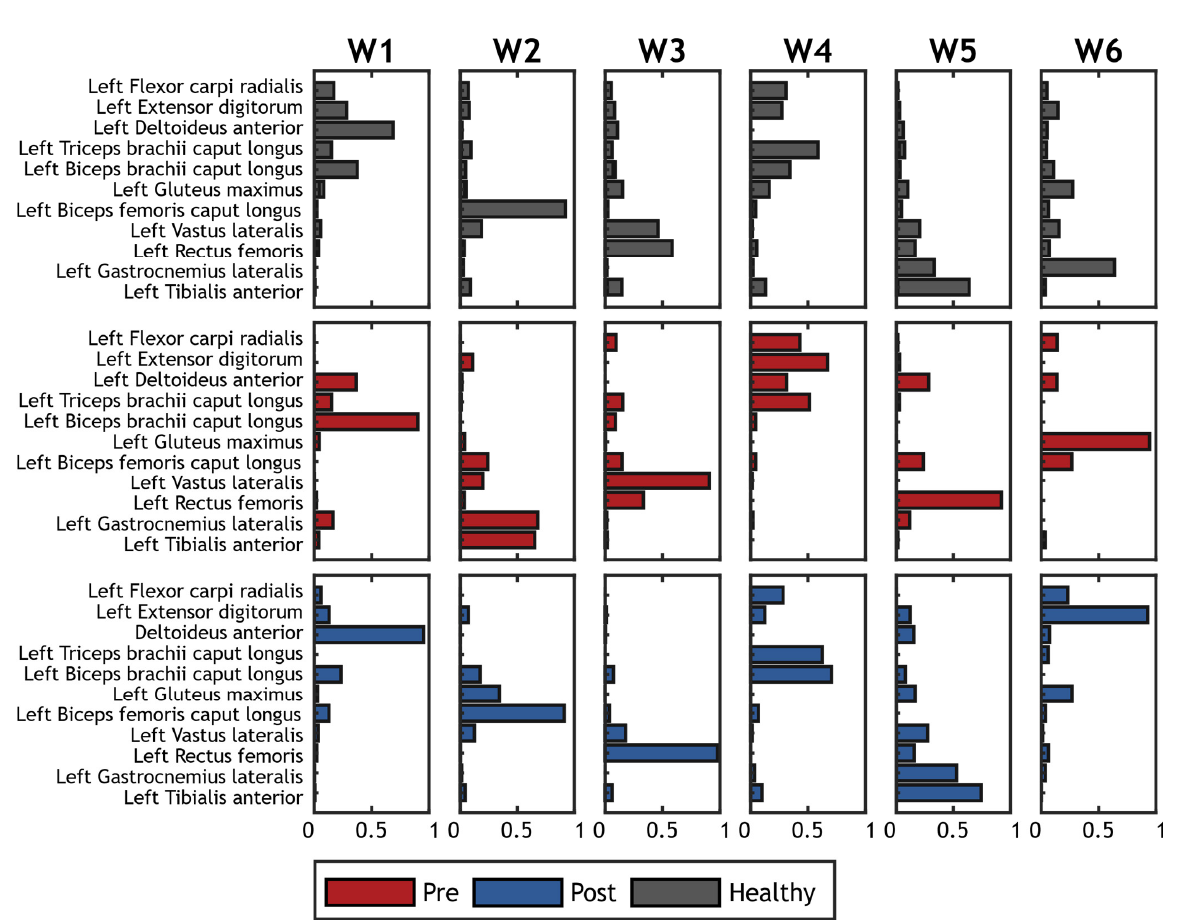
Figure 5. Example of synergies extracted on a hemiplegic patient. Spatial synergies before treatment are represented in red; spatial synergies after treatment are represented in blue. Grey bars show the corresponding reference synergies achived averaging synergies on the control group. The mSS obtained for all groups of subjects is presented in Figure 6.